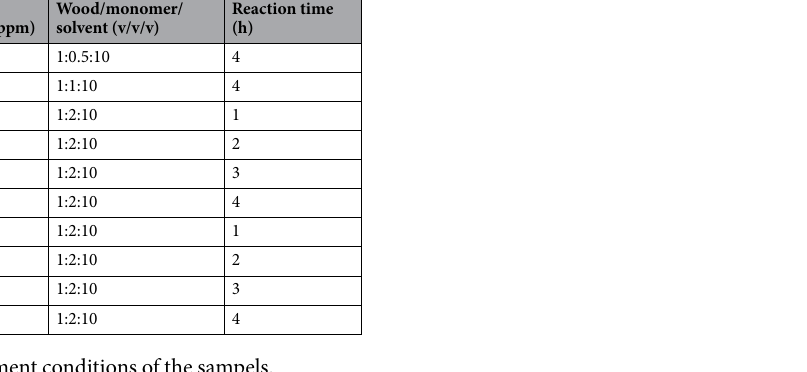
Table 1. Treatment conditions of the